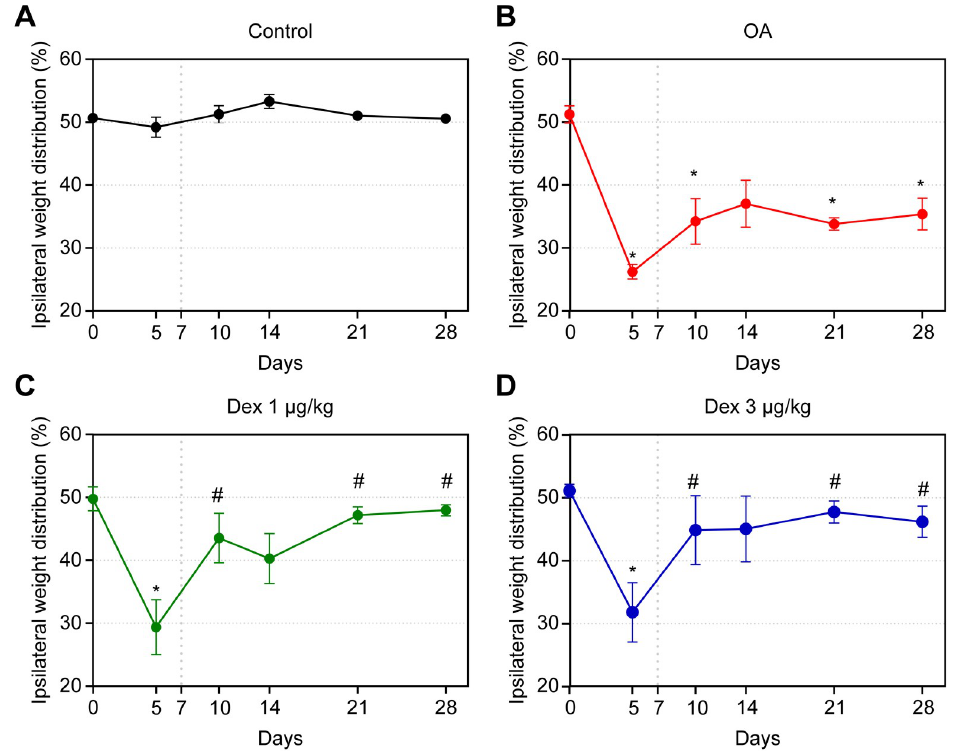
Fig 2. Assessment of weight distribution on the hind paws in rats treated with normal saline (0.9% NaCl, i.a.) or dexmedetomidine at doses of 1 μ g/kg or 3 μ g/kg, i.a. Symbols and vertical lines represent the mean ± standard error of the mean. The vertical dotted lines represent the onset of treatment. � indicates a significant difference compared with the control group. # indicates a significant difference compared with the OA group.